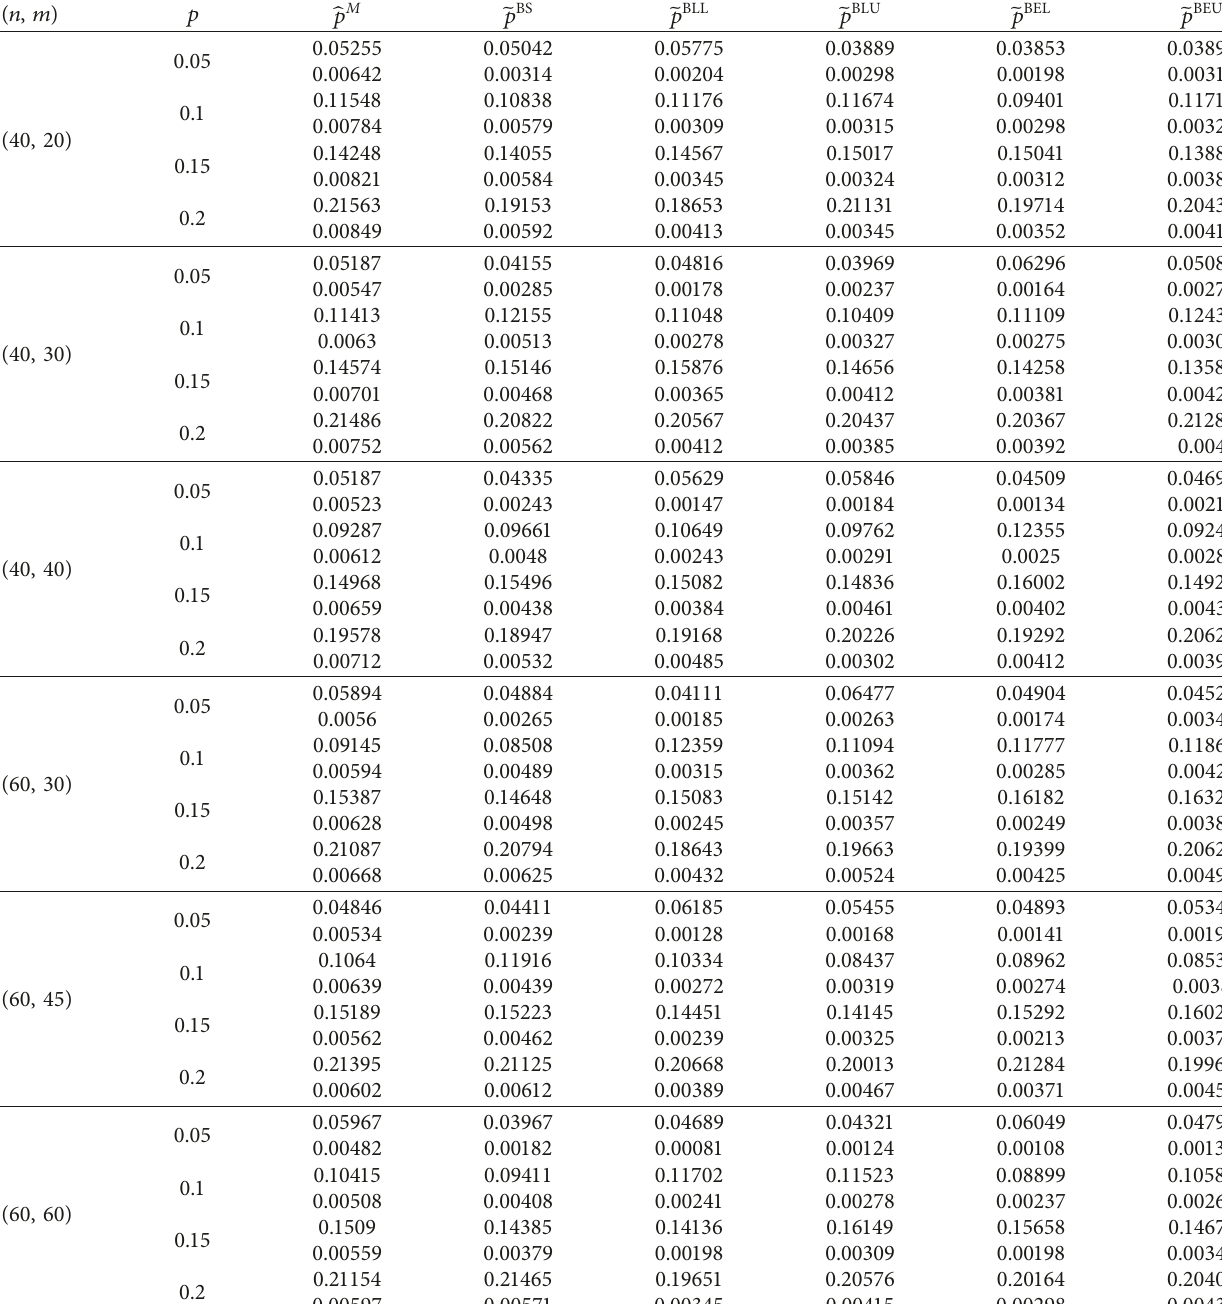
Table 8: ML and Bayes estimate of p with respected MSE’s for different values of p and m for n